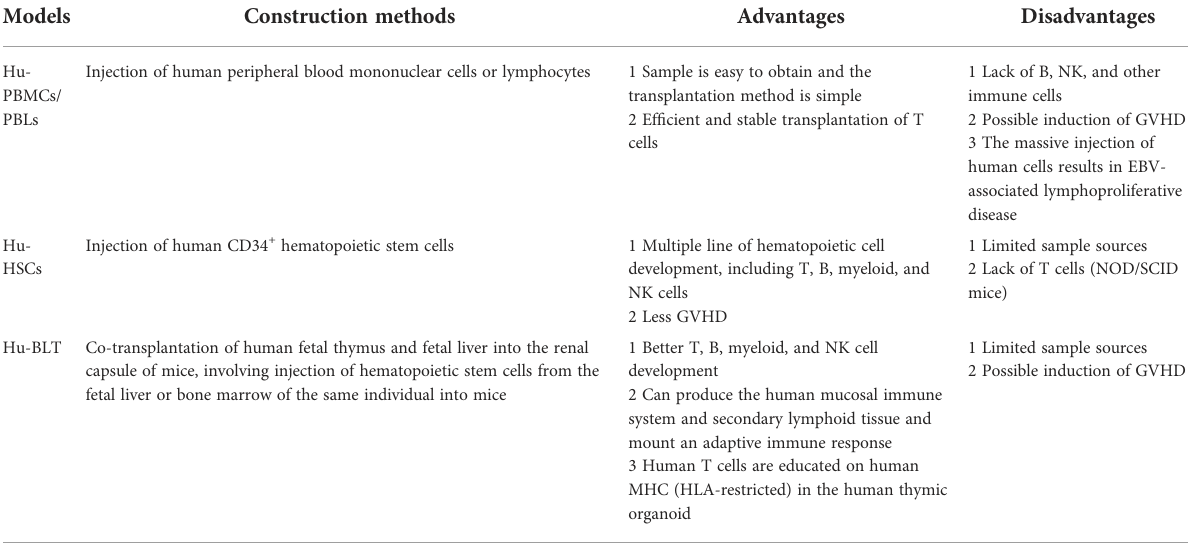
TABLE 1 Different construction methods and characteristics of humanized mice.